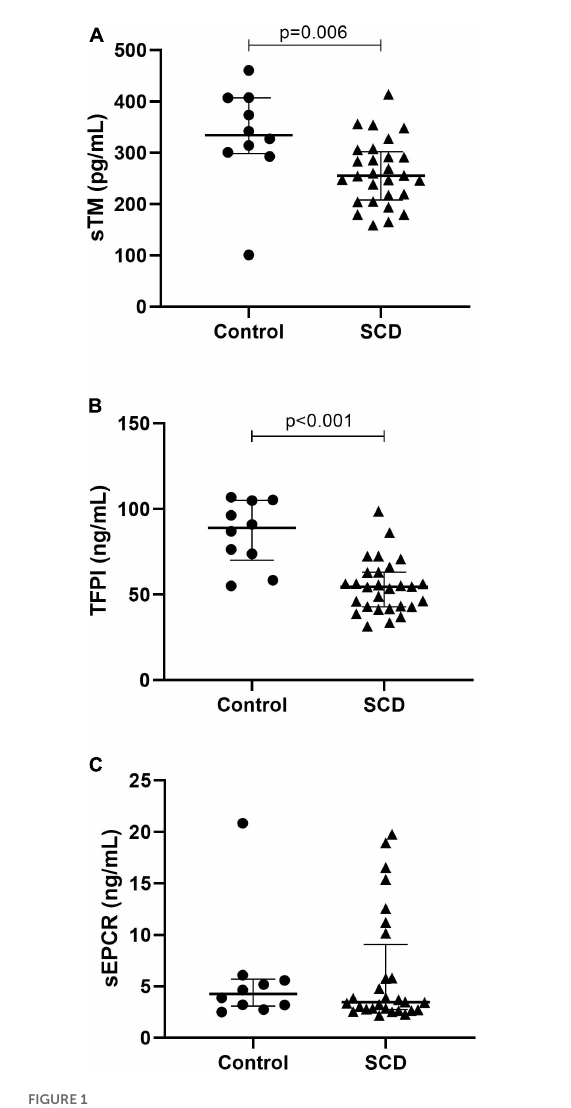
FIGURE1 Anticoagulant protein expression in sickle cell disease. With thrombomodulin (A) , tissue factor pathway inhibitor (B) , and soluble endothelial protein C receptor (C) . TFPI, tissue factor pathway inhibitor; sEPCR, soluble endothelial protein C receptor, TM, thrombomodulin; SCD, sickle cell disease. Data are expressed as median [IQR]. P -values comparing control group and SCD patients in steady state are from Mann–Whitney